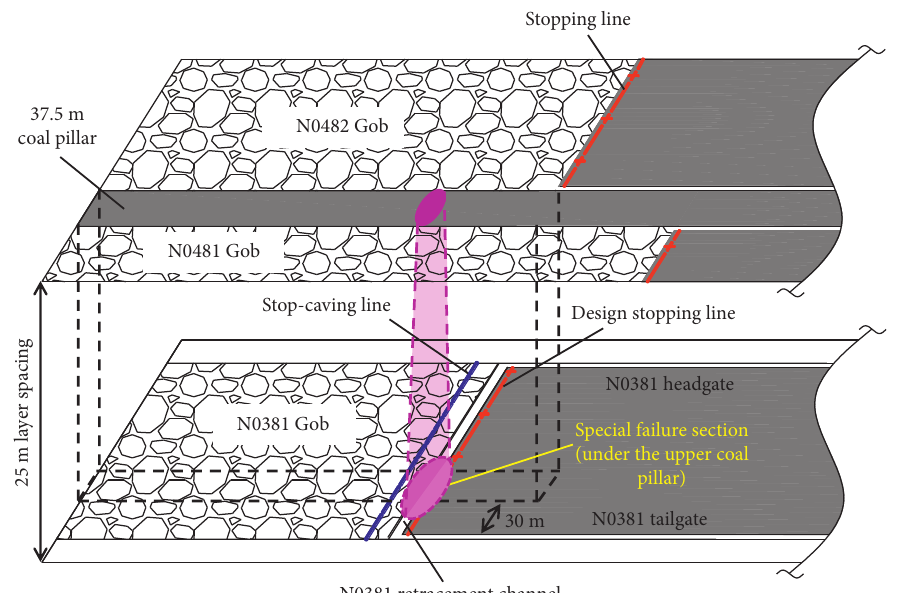
Figure 2: Space location relationship of 3# and 4# coal seams.